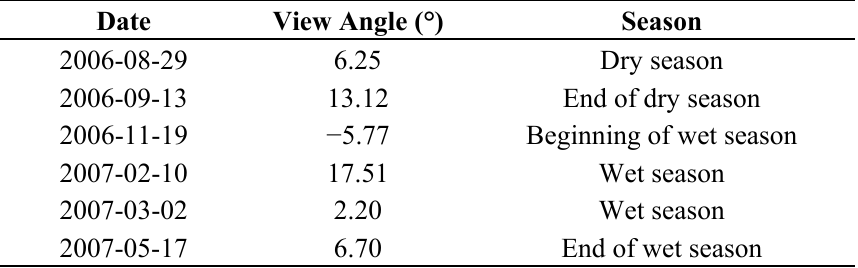
Table 3. EO-1 Hyperion data acquisitions over the study